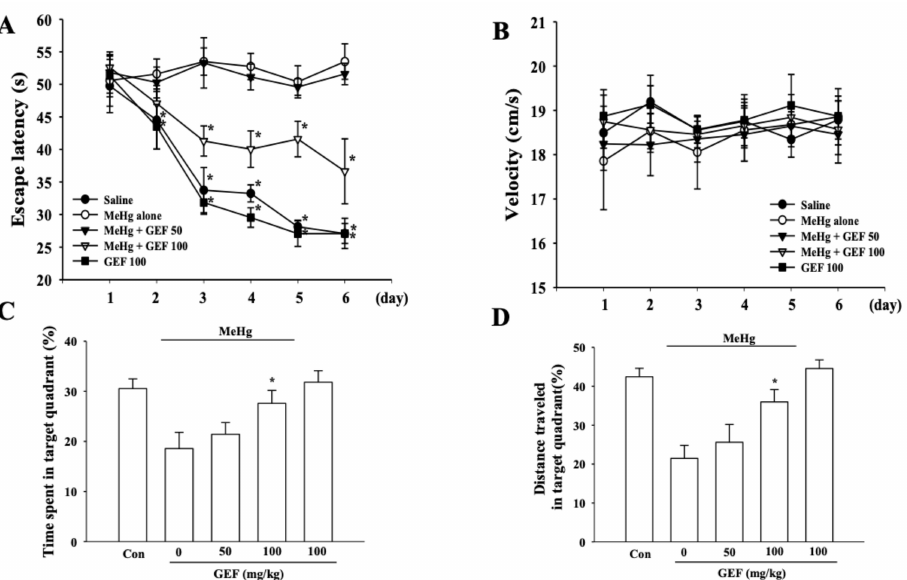
Figure 6. Morris water maze test of control, MeHg alone, MeHg + GEF (50 or 100 mg / kg, 3 weeks, p.o.) and GEF (100 mg / kg) alone groups. ( A ) Long-term oral treatment of MeHg (2 mg / kg, p.o) group need more time to find target. Long-term treatment of GEF (50 and 100 mg / kg, 3 weeks, p.o) group has tendency to find target early. ( B ) Velocity (cm / s) for each group. ( C ) Increase of time spent in target quadrant means mice remember the target space. Time spent in target quadrant in the Morris water maze during a 60 s spatial memory trial 24 h after the last training session. It shows that GEF 100 mg / kg group spent more time in the target quadrant. ( D ) Percentage of distance spent in the target quadrant on the seventh day to assess memory strength in mice. Increase of distance traveled in target quadrant means mice remember the target space. GEF 100 mg / kg groups have more distance traveled in target quadrant. For C–D, data are representative of two independent experiments analyzed using unpaired 2-tailed t-tests. n = 10; *p < 0.01, compared with MeHg